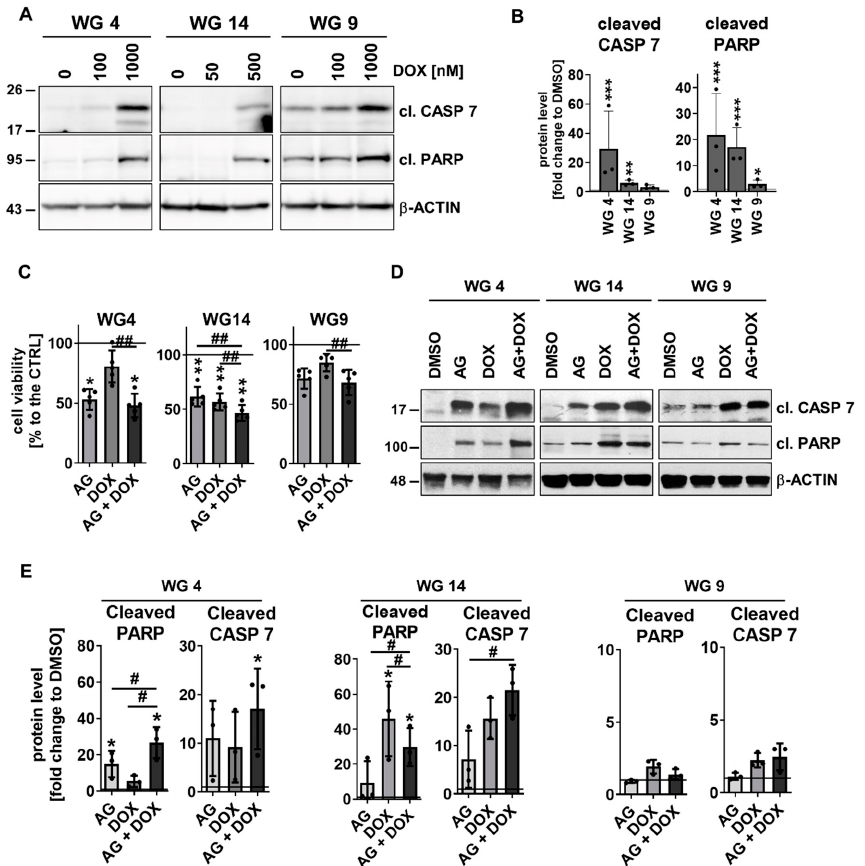
Figure 7. AG1478-enhanced cytotoxicity exerted by DOX in primary glioma cell cultures. ( A ) Representative immunoblots showing the apoptosis markers: cleaved caspase 7 and cleaved PARP (cl. CASP 7, cl. PARP, respectively) in WG4, WG14 and WG9 cells treated with DOX for 48 h. ( B ) Densitometric quantification of effects of DOX at the high doses: 0.5 and 1 mM. The level of a protein of interest in control cells equals 1 and is marked by a solid black line. β -ACTIN was used as a loading control. Statistical significance was determined by one-way ANOVA followed by Dunnett’s post